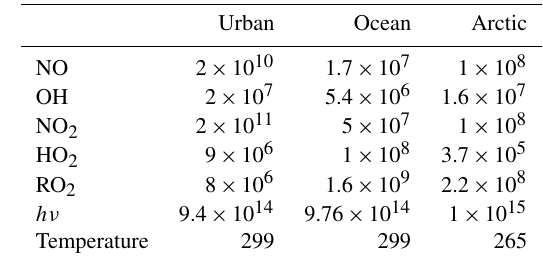
Table 1. Case environment conditions. Photochemical concentra- tions are measured per cubic centimeter (cm − 3 ), temperatures in Kelvin